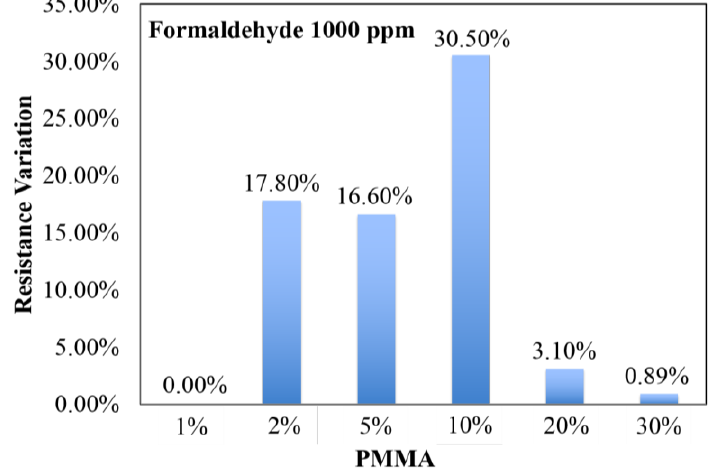
Figure 3. The formaldehyde sensing result of different PMMA blending concentrations with 2%